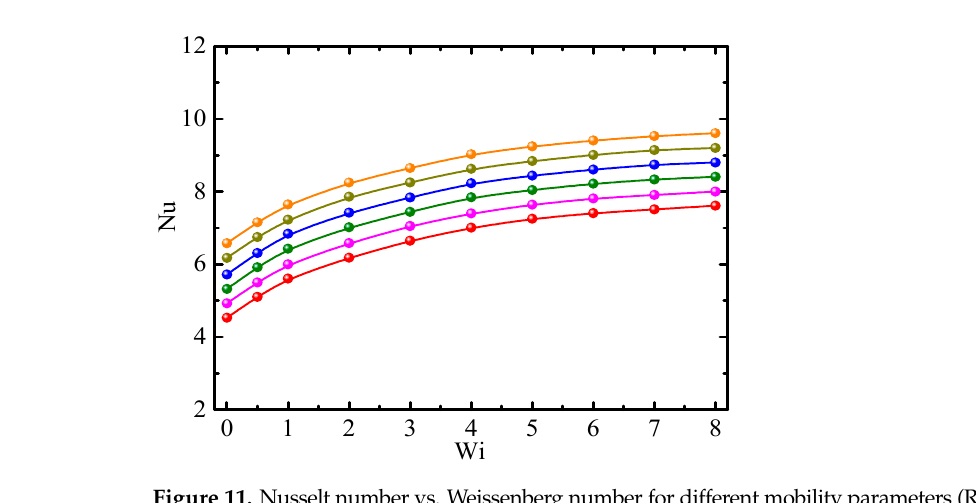
Wi Figure 10. Nusselt number vs. Weissenberg number for different Reynolds numbers ( β 0 = 0.2, Φ = 1.0%, α = 0.2). ⸺ ● ⸺ : Re = 0.5; ⸺ ● ⸺ : Re = 1; ⸺ ● ⸺ : Re = 2.5; ⸺ ● ⸺ : Re = 10; ⸺ ● ⸺ : Re = 100; and ⸺ ● ⸺ : Re = 500. Figure 11 shows the relationship between Nu and Wi for different α . Nu increases with the increase in α , and the growth rate of Nu is almost the same when 0 < α < 0.5, showing the increase in heat transfer depends linearly on α . The larger α is, the more